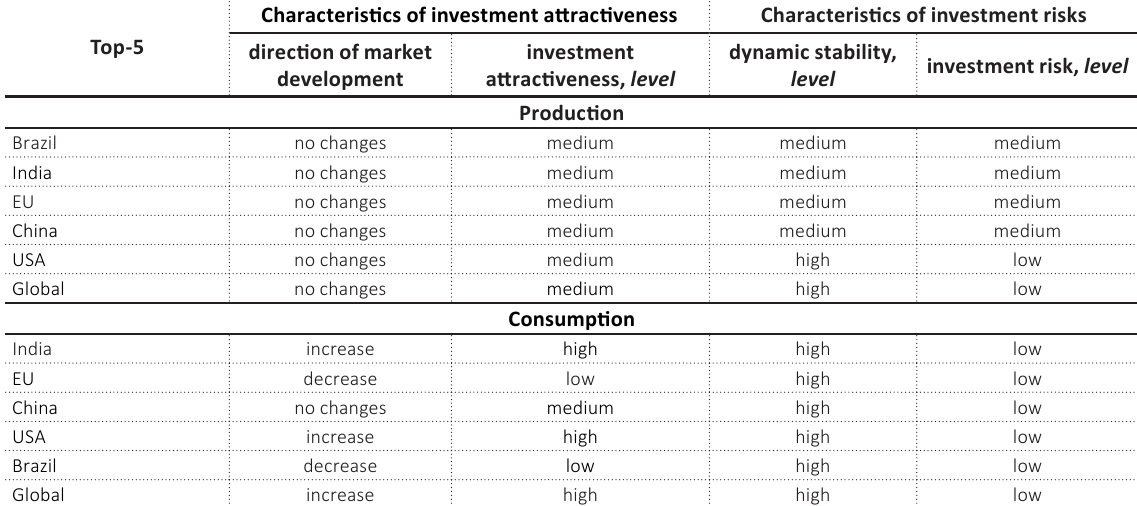
Source: Authors’ elaboration.